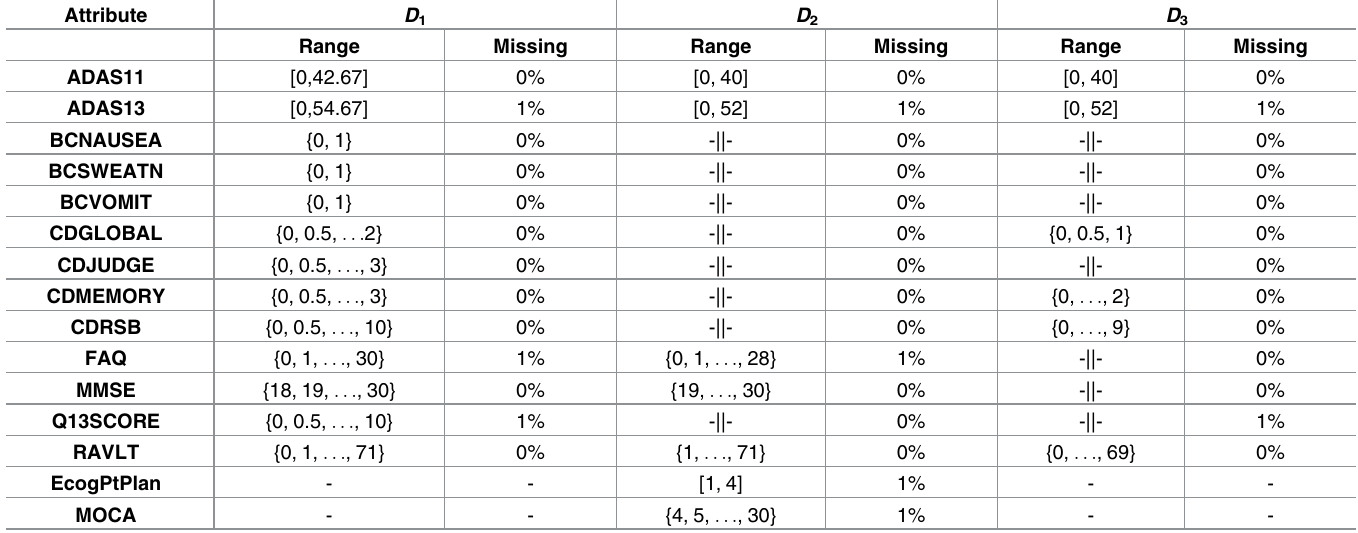
Table 4. Information about value range and percentage of missing values for clinical attributes discussed in the text. Absenceof an attribute from a dataset is denotedwith “-” in the range and missing columns. If some dataset has equal range as D 1 , this is denotedwith “-||-” in the appropriate field.